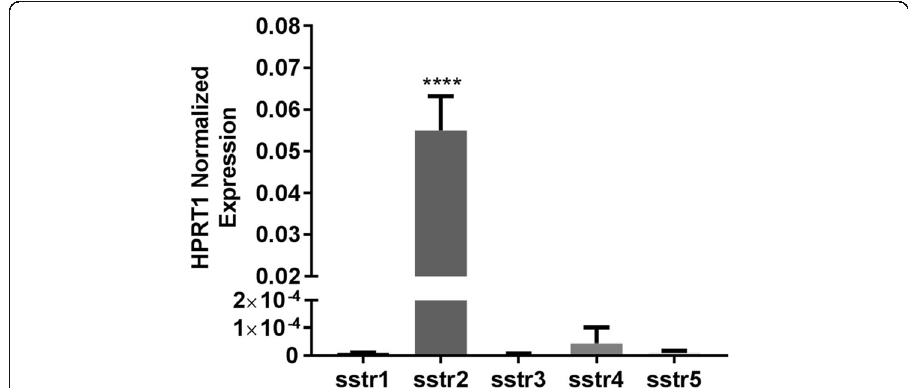
Fig. 3 Relative transcriptional expression of sstr subtypes normalized to housekeeping gene